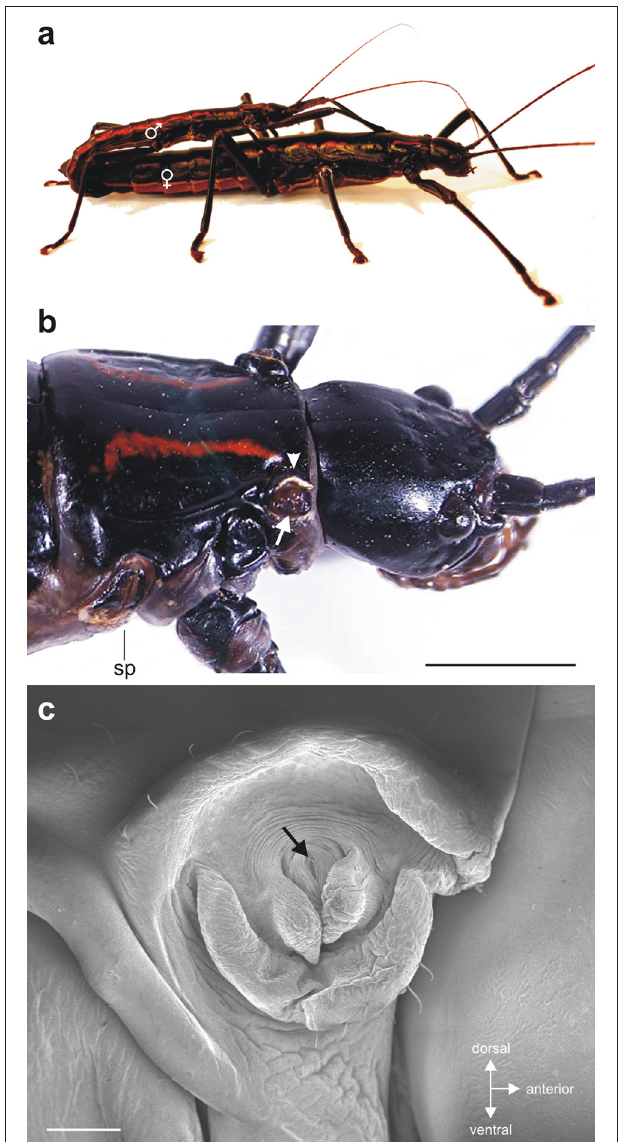
FIGURE 1 | (a) Couple of Anisomorpha paromalus with male on top and female below. (b) The gland opening (white arrow) is located below a cuticular ridge (arrowhead) at the anterio-dorsal edge of the pronotum. (c) Scanning electron micrograph of the small release opening (black arrow) surrounded by membranous structures. Scales: (b) = 4mm; (c) = 250 µ